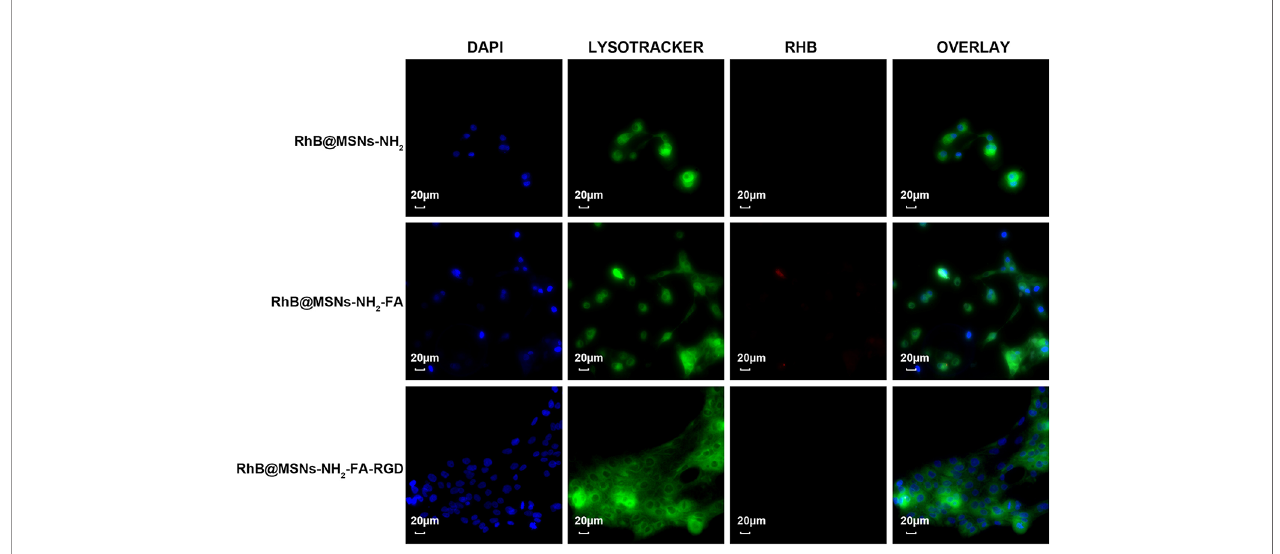
FIGURE 7 | Fluorescence microscopy images of MCF-10A cells incubation with RhB@MSNs-NH 2 , RhB@MSNs-NH 2 -FA, and RhB@MSNs-NH 2 -FA-RGD for 4 h. Blue fl uorescence fi eld: nucleus; green fl uorescence fi eld: cytoplasm; red fl uorescence fi eld: a dye used to label nanocarriers. Scale bar: 20 m